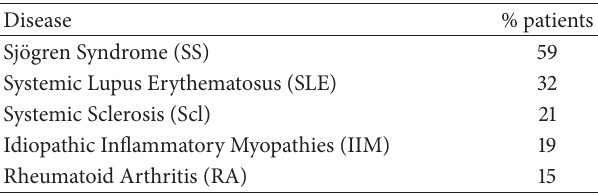
Table 2: Classical clinical associations of anti-Ro52 antibodies. Disease %